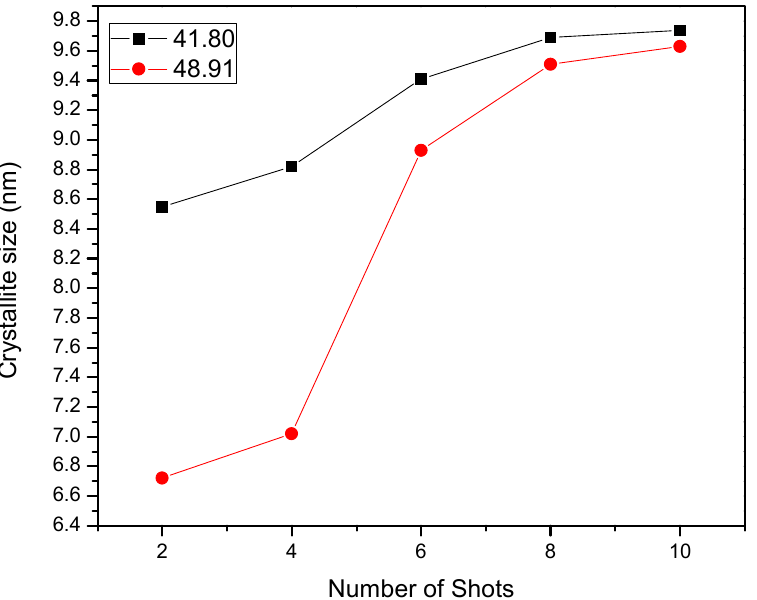
Figure 4. Variation in crystallite size for PTFE-coated Ti samples as a function of number of shots.